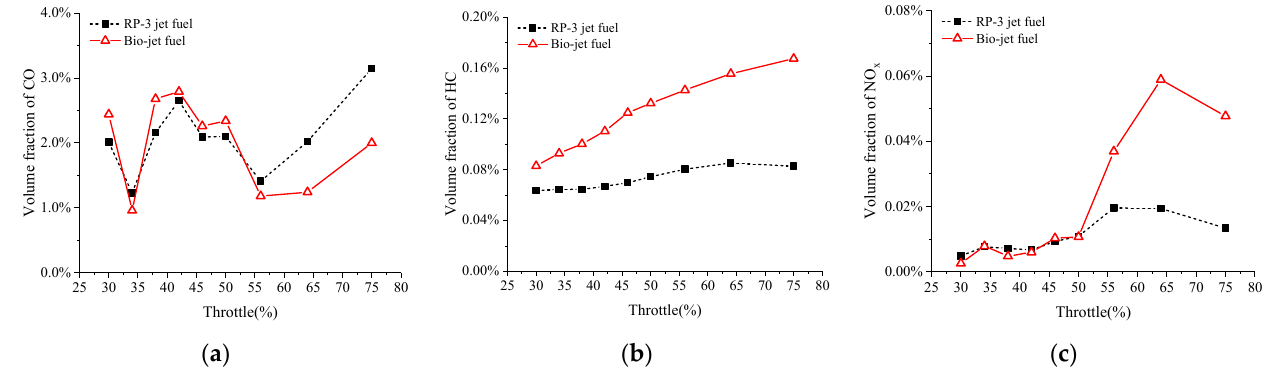
Figure 11. Volume fractions of the ( a ) CO, ( b ) HC, and ( c ) NO x in the exhaust gas against throttle opening.